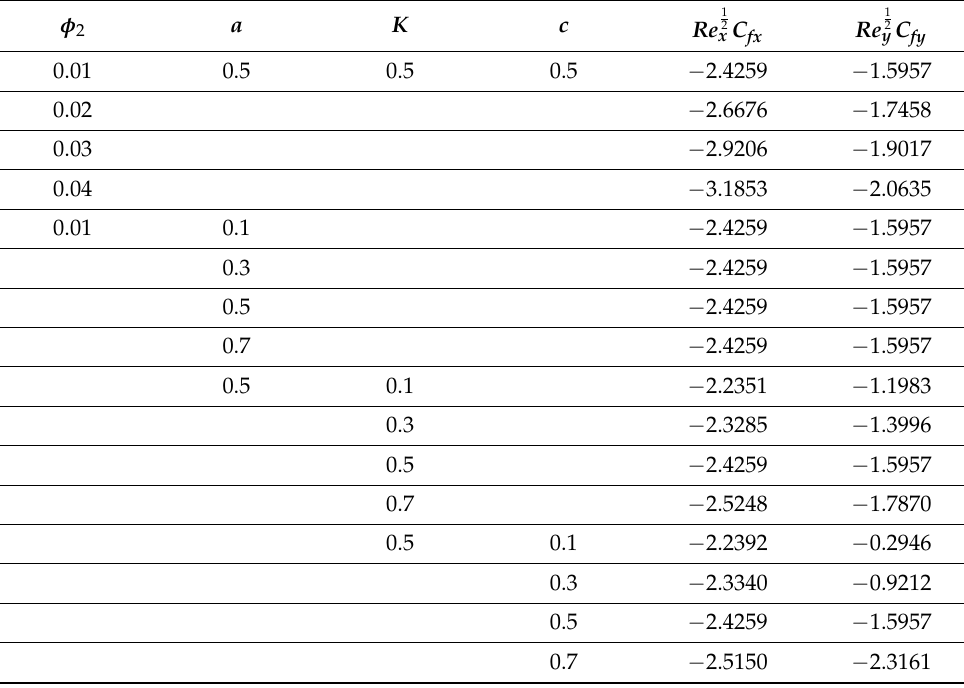
1 1 2 x C fx and Re 2 y C fy for ( Al 2 O 3 − Cu )/Water.